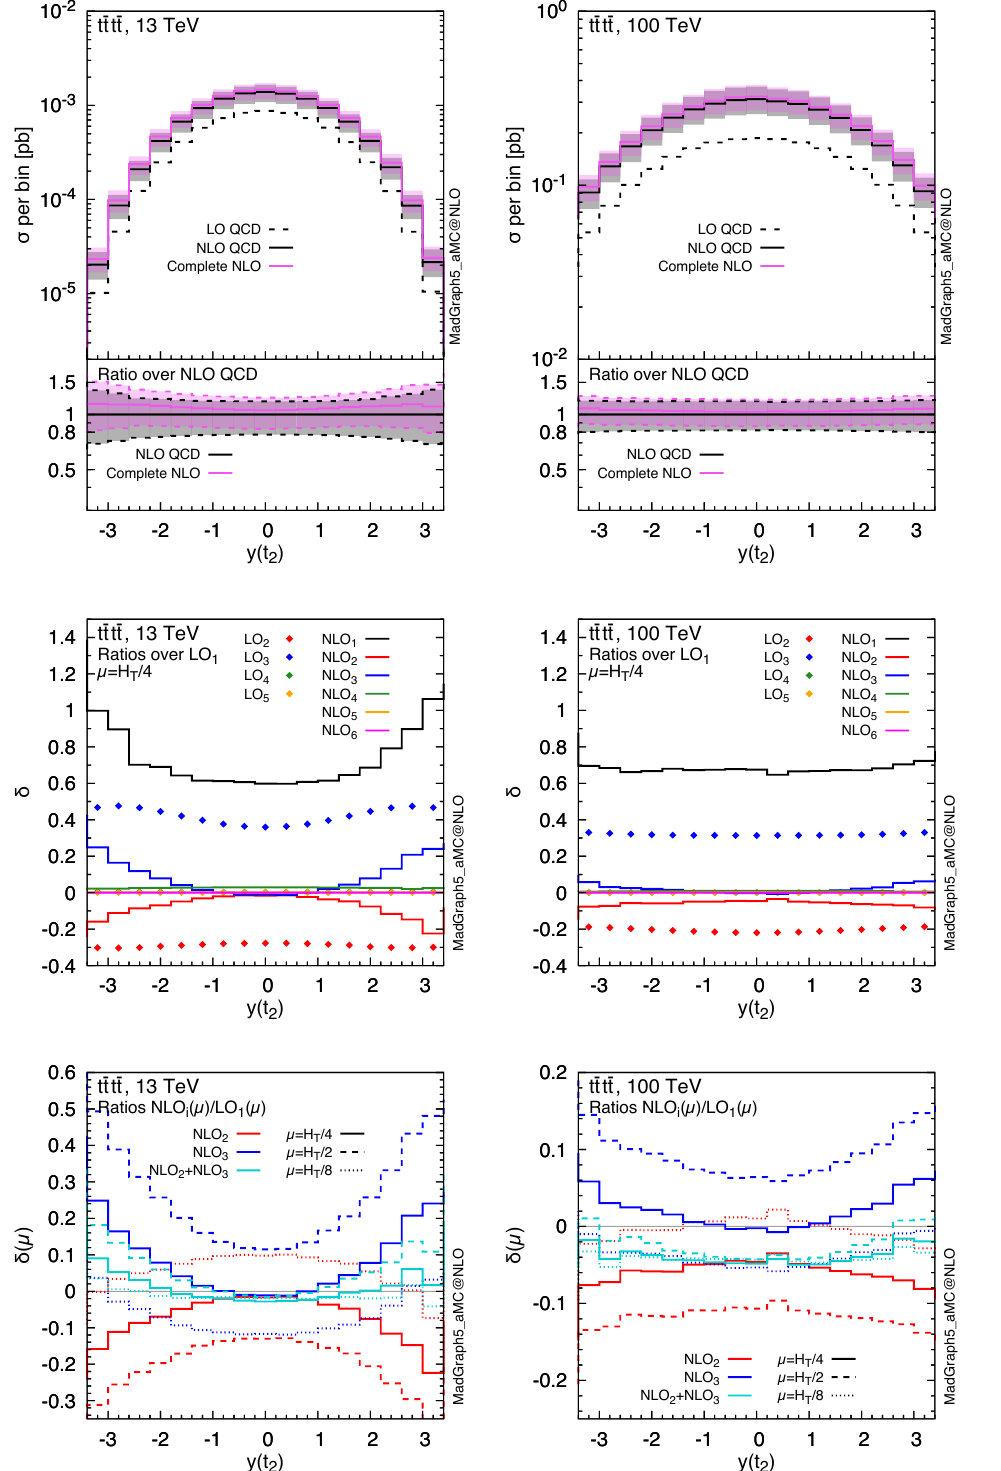
Figure 12 . The y ( t 2 ) distribution in t (cid:22) tt (cid:22) t production. See the caption of (cid:12)gure 9 for the description of the